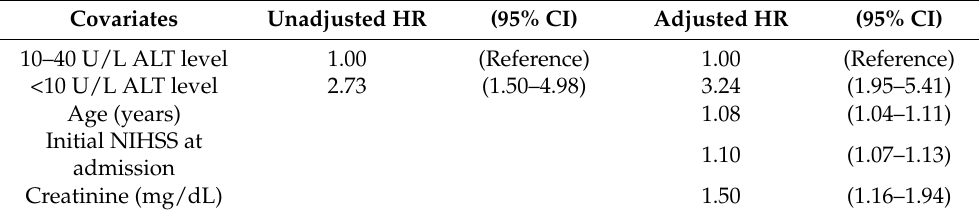
Table 2. Unadjusted and adjusted hazard ratios and 95% CI for all-cause mortality, according to the ALT level.